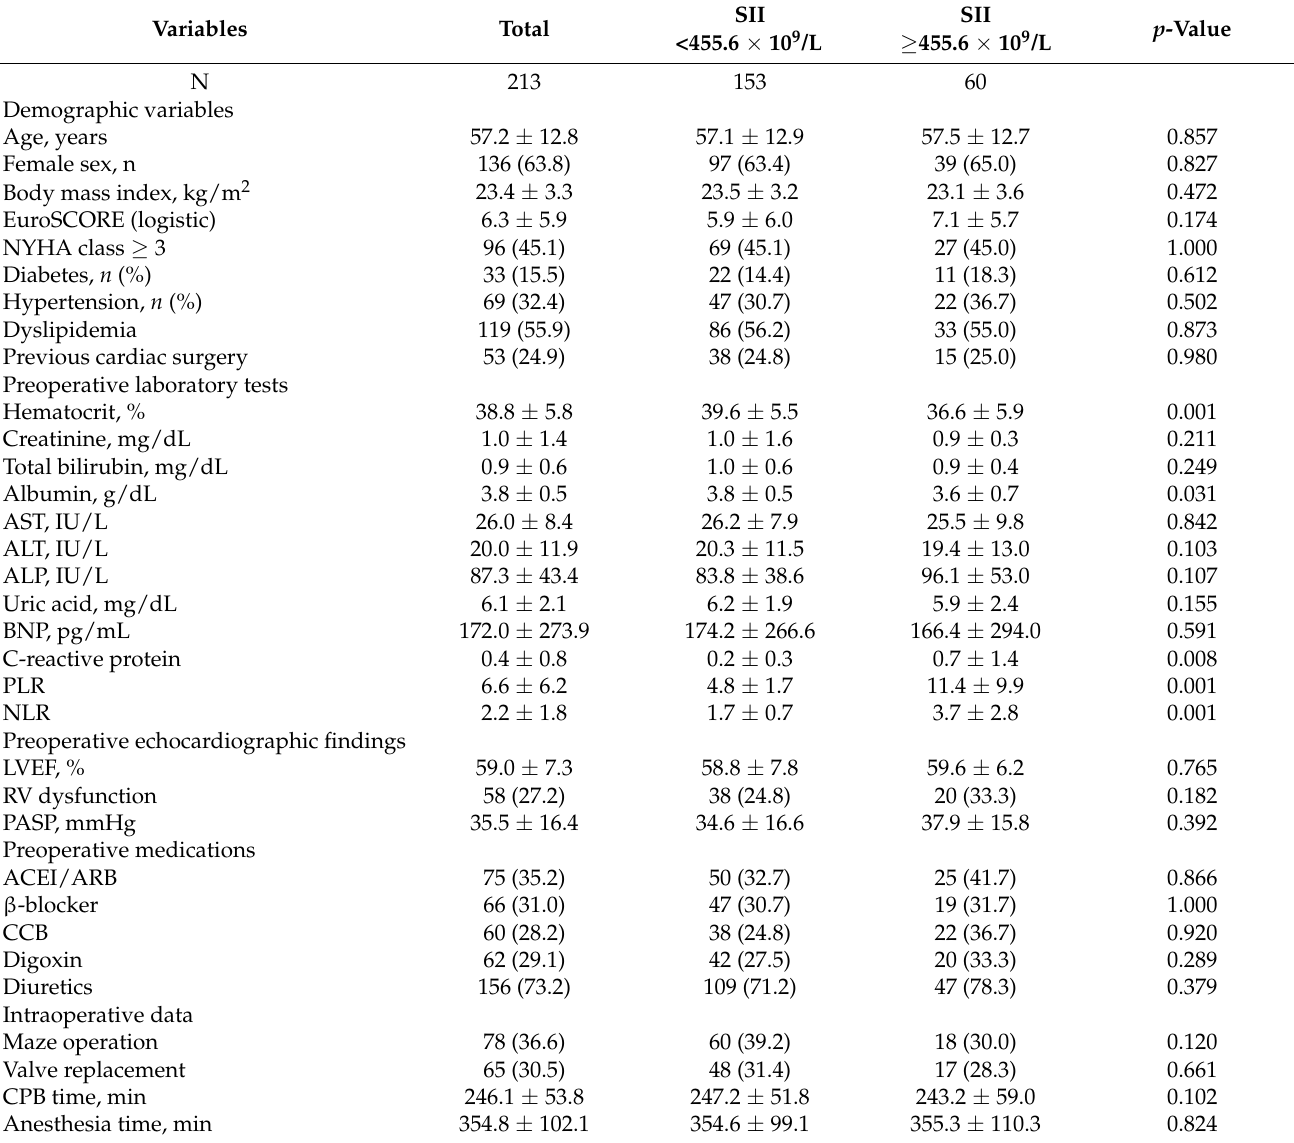
Table 1. Baseline and operative characteristics of study